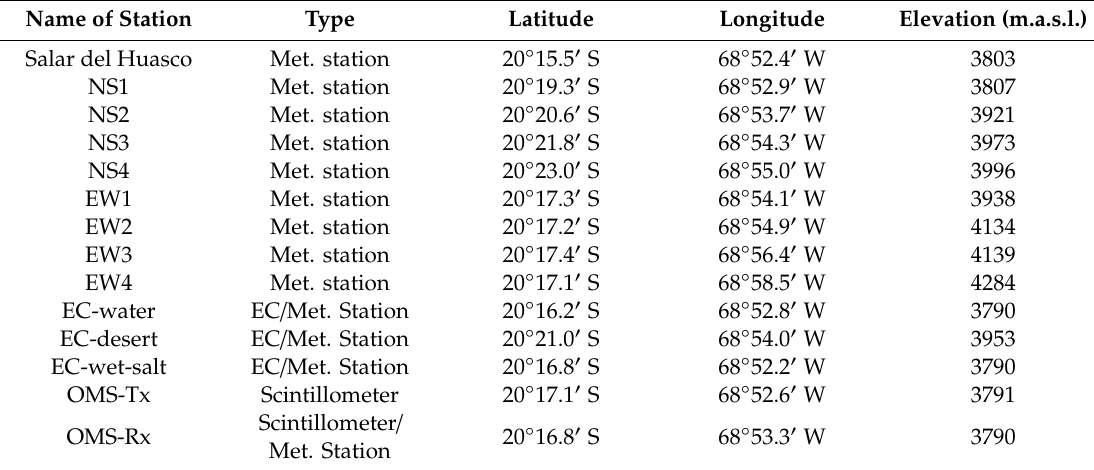
Table 2. Geographical information of the meteorological stations, eddy covariance (EC) systems, and optical-microwave scintillometer (OMS). OMS-Tx and OMS-Rx refer to the OMS transmitter and receiver,